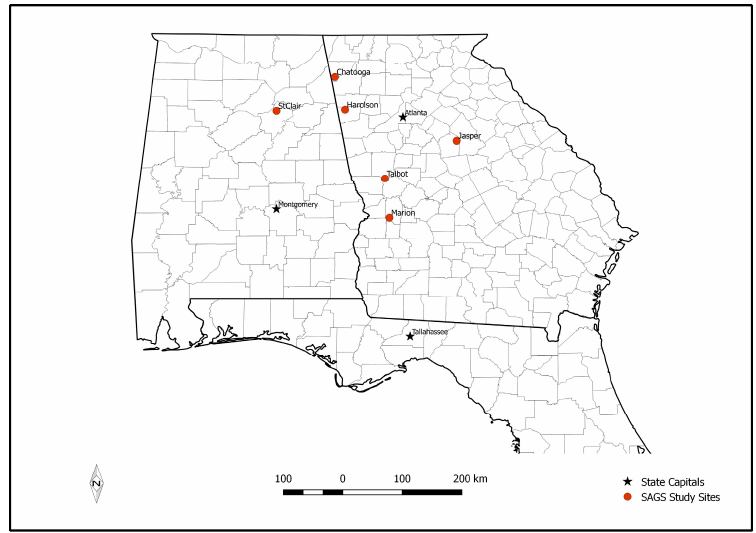
Figure 1. Location of non-thinned Plantation Management Research Cooperative (PMRC) South Atlantic Gulf Slope (SAGS) Culture × Density installations. (County name indicated at each site). Table 1. Geographic details, soil details, and site index values for six Plantation Management